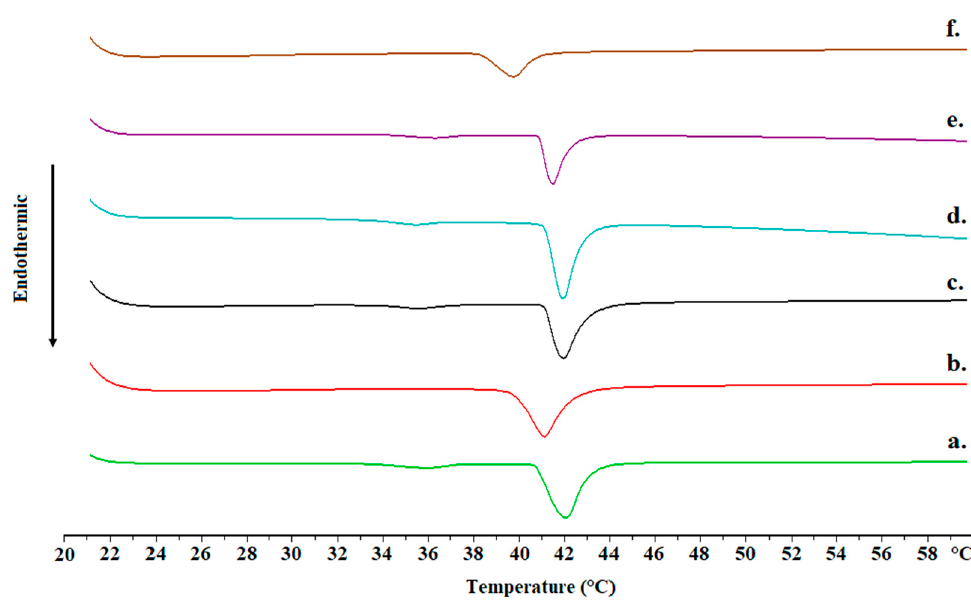
Figure A1. DSC heating thermographs of ( a ) DPPC, ( b ) DPPC:quercetin 9:0.1, ( c ) DPPC:rutin 9:0.1, ( d ) DPPC:rutin 9:0.5, ( e ) DPPC:RGMS1 9:0.1, and ( f ) DPPC:RGMS1 9:0.5a.